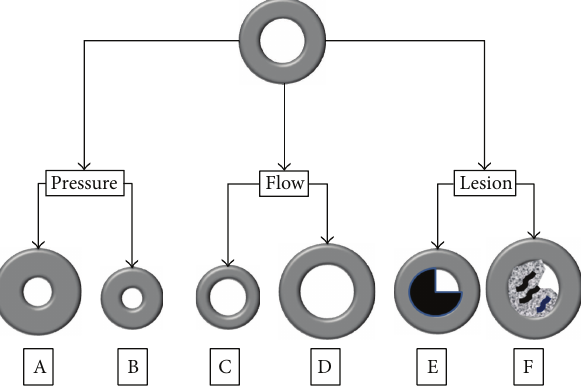
Figure 1: Changes are predominantly in media-to-lumen ratio (M/L), changing the vessel wall width for increased muscle mass (Figure 1(A)) or in the reorganization of cellular and noncellular elements (Figure 1(B)). Another mechanism of remodeling mainly involves changes in the dimensions of the lumen (Figures 1(C) and 1(D)). In this case, the restructuring of the active components and cell signals does not result in significant changes in the dimensions of the vascular lumen. Another form of vascular remodeling is microcirculation rarefaction (Figures 1(E) and